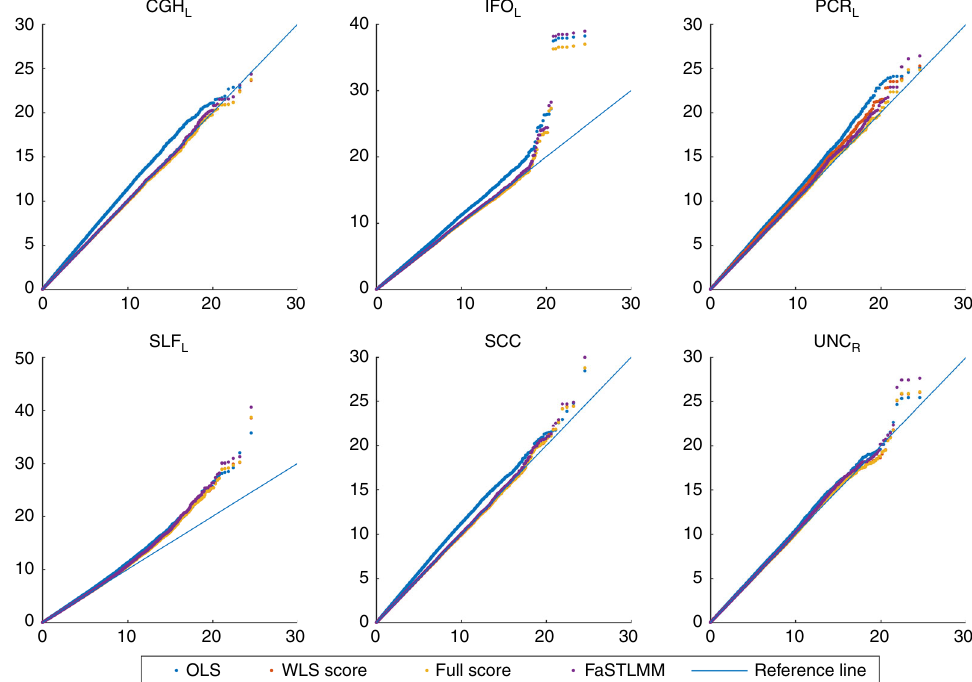
Fig. 7 QQ plot for comparing FaST-LMM and the score test based on the simpli fi ed REML function using the WLS-REML random effect estimator with the linear regression with MDS as nuisance fi xed effects (Real data analysis). Each plot corresponds to different ROIs. These plots show either an identical distribution or slightly larger values for the OLS approach. However, the OLS approach has poor genomic control (Supplementary Figure